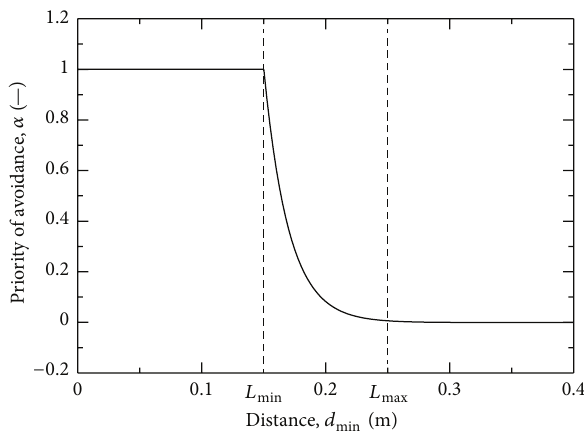
Figure 6: Priority of avoidance, 𝛼 .